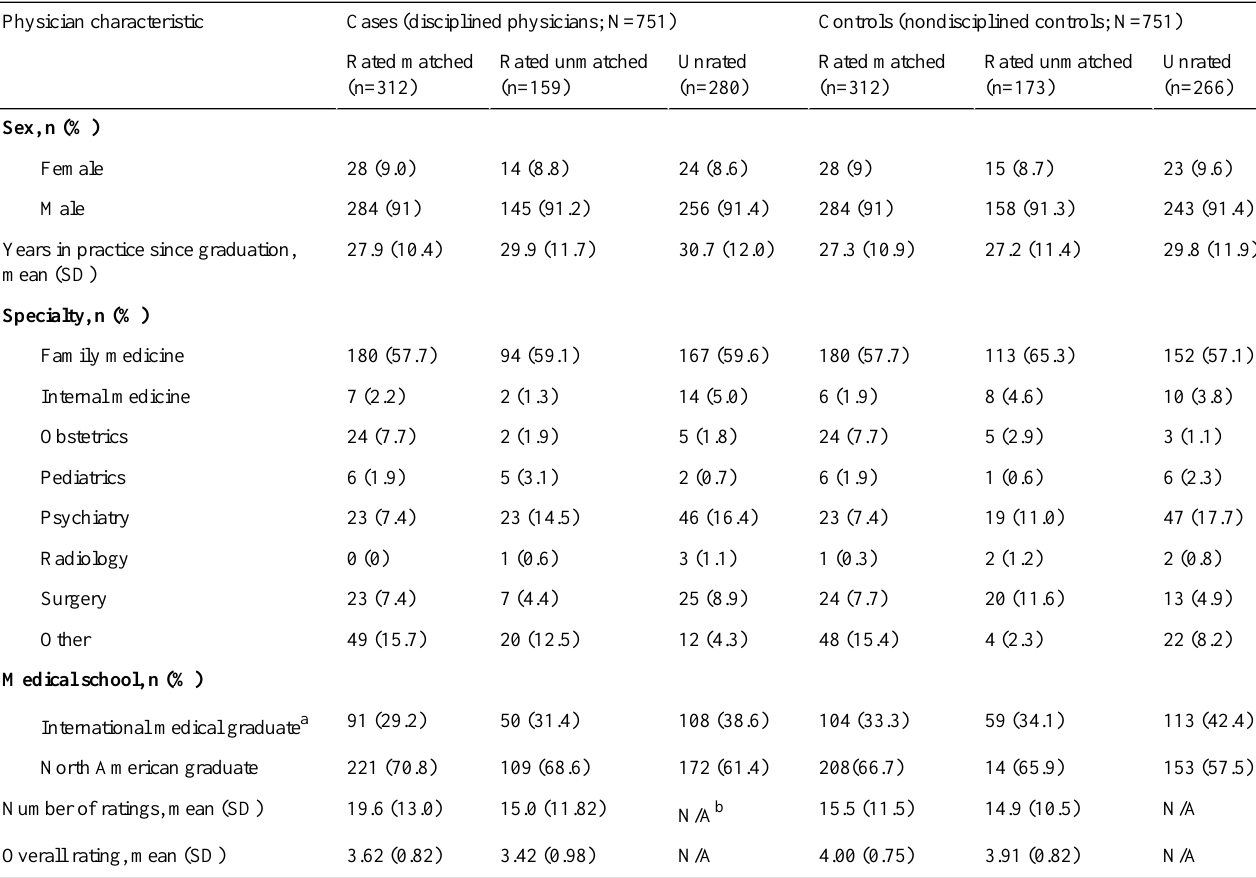
Table 1. Characteristics of cases (751 disciplined physicians; 2000-2013) and controls (751 nondisciplined physicians, matched for gender, years since graduation, and city of practice [where